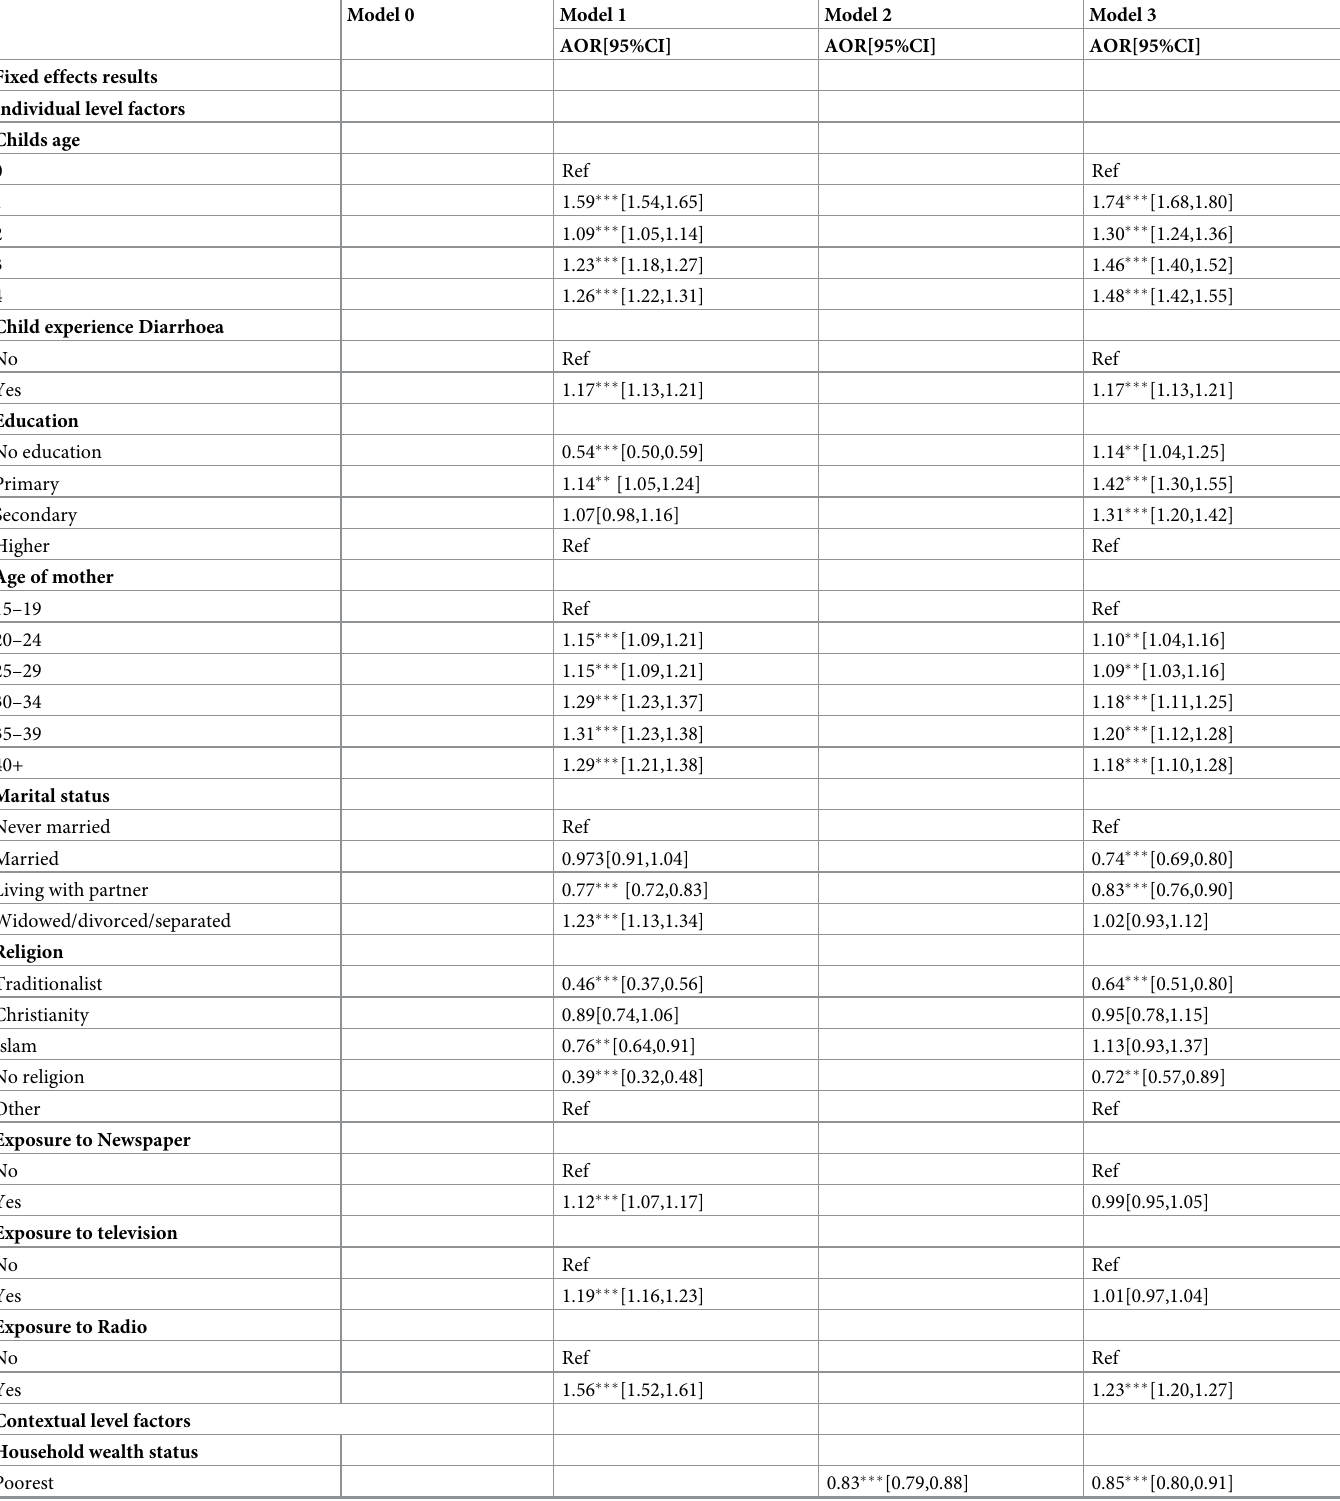
Table 3. Predictors of safe child stool disposal practices among women in